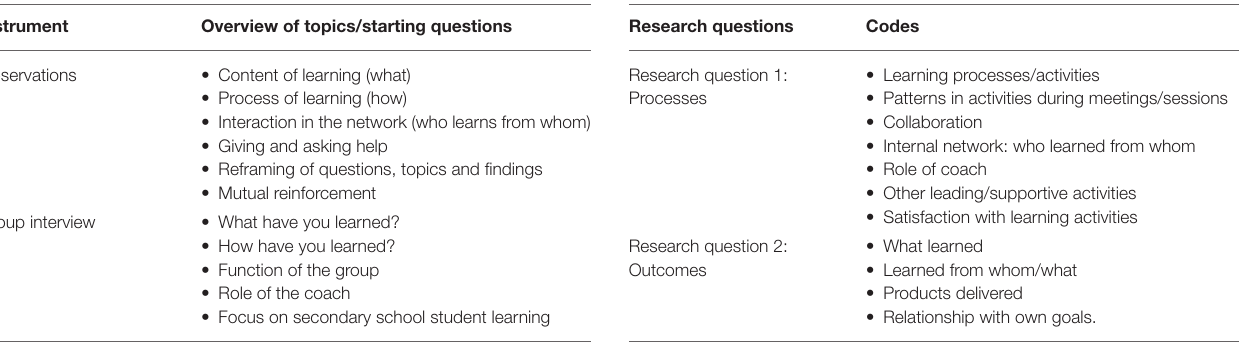
TABLE 3 | Overview of instruments. TABLE 4 | Overview of codes used in this